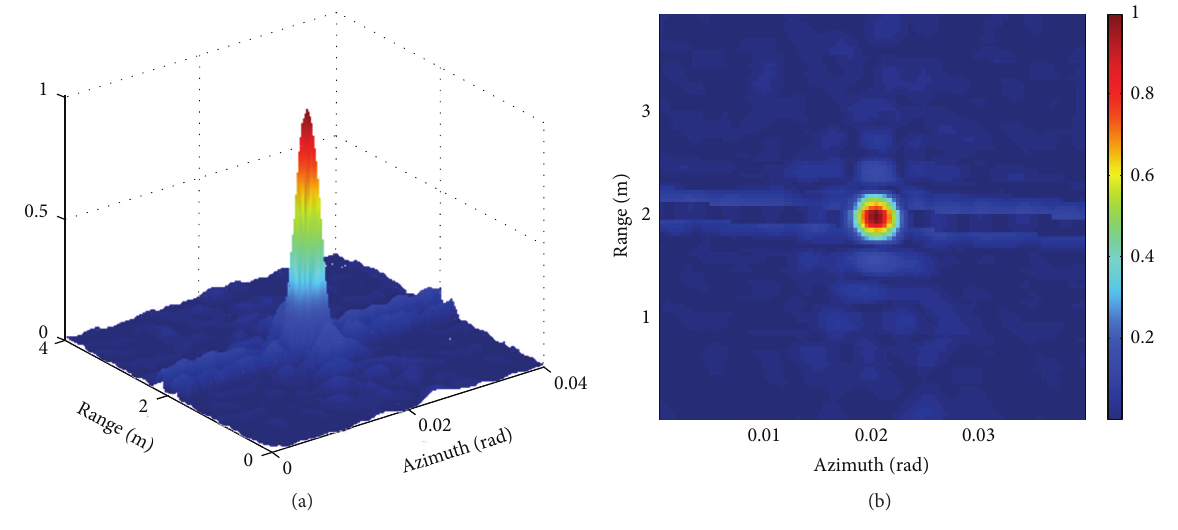
Figure 5: The PSF of point (0.02 rad ,2 m ) ; (b) is the top view of